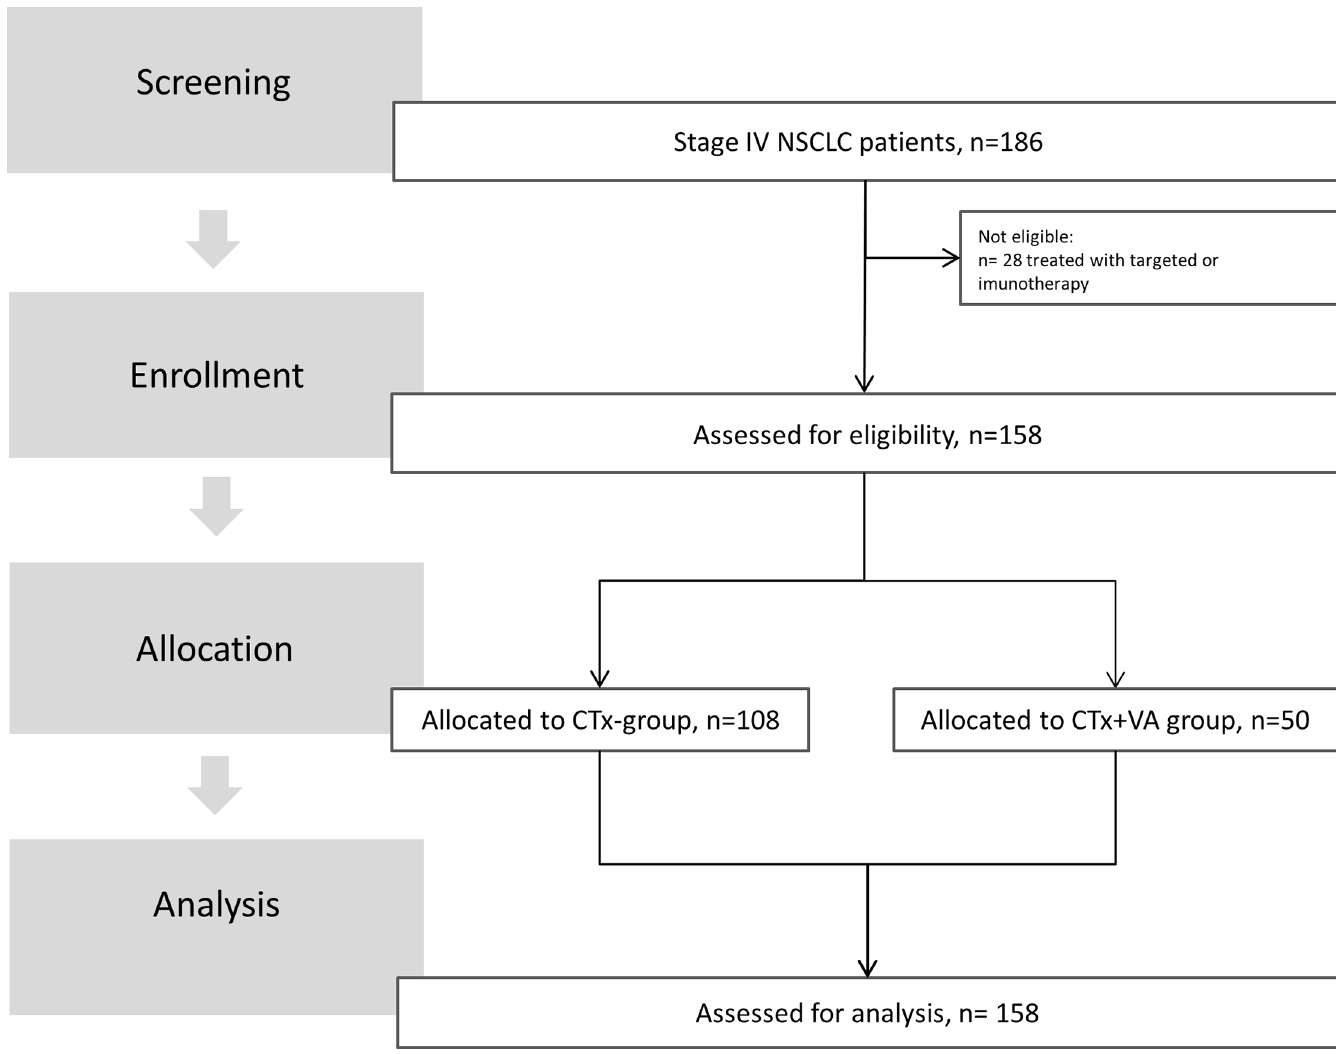
Fig 1. Flow chart of the study population. NO, network oncology; CTx, Chemotherapy; VA, Viscum album L., mistletoe.